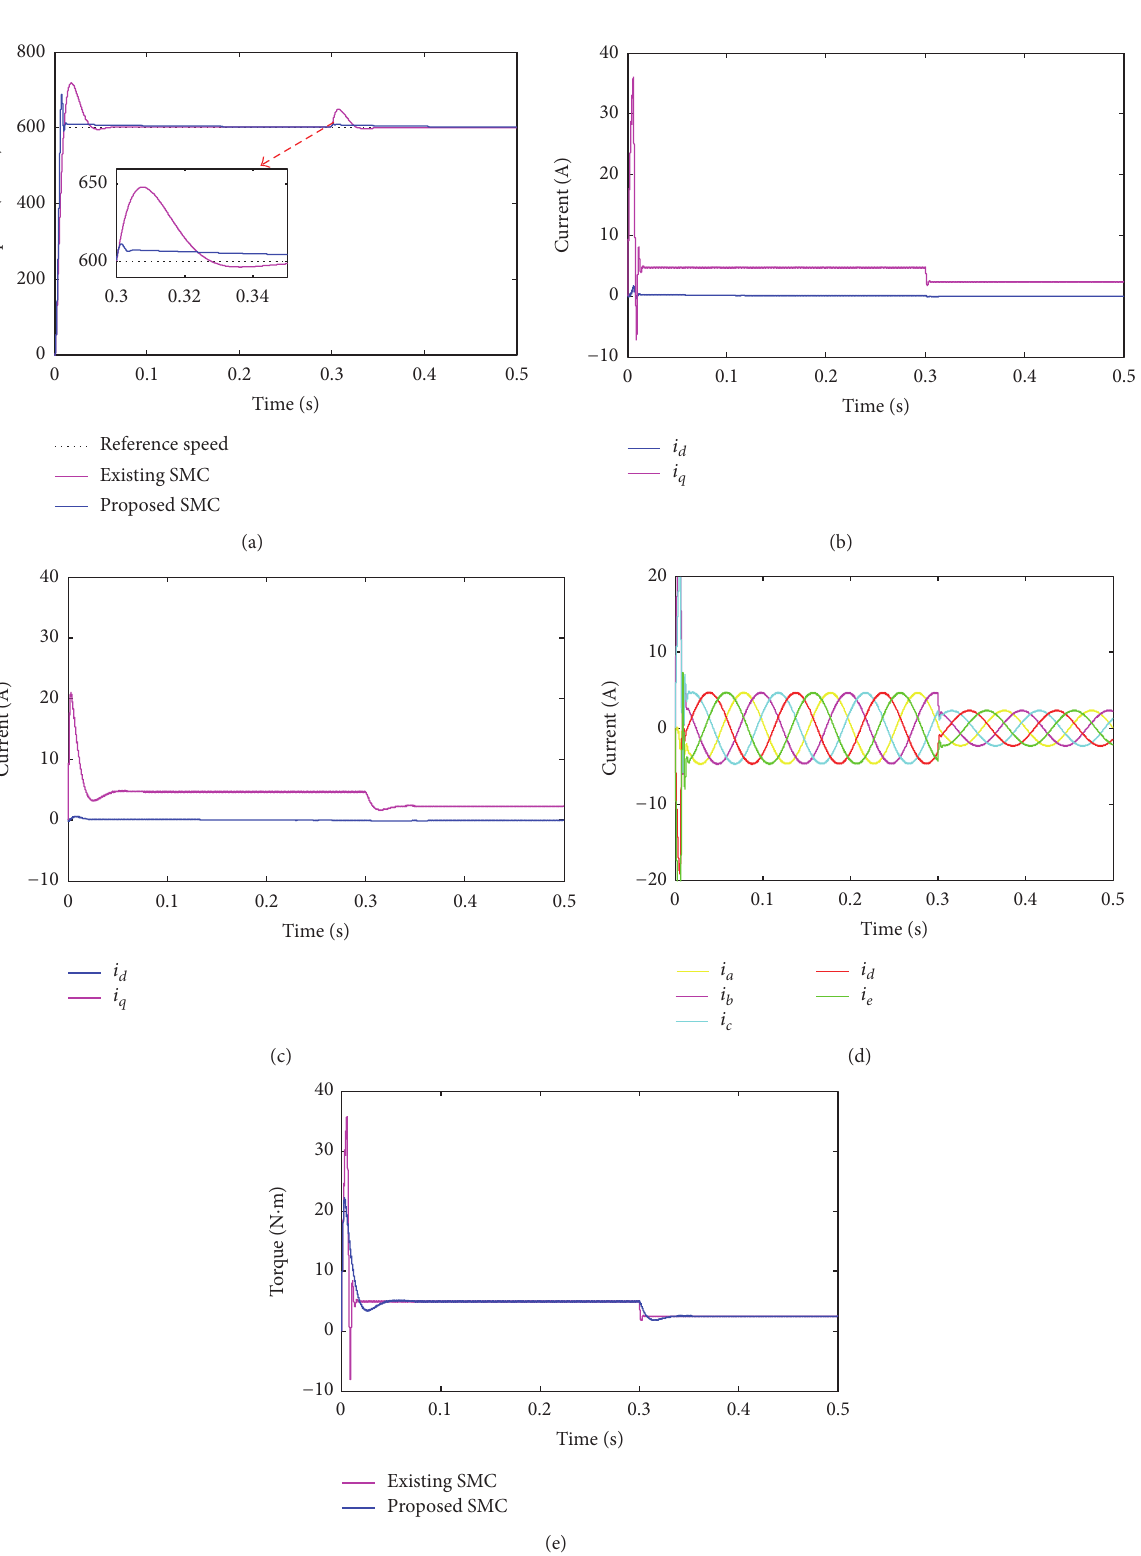
Figure 7: Simulation results when decreasing load from 5 N ⋅ m to 2.5 N ⋅ m. (a) Speed response. (b) Current waveforms 𝑖 𝑑 and 𝑖 𝑞 under the existing SMC. (c) Current waveforms 𝑖 𝑑 and 𝑖 𝑞 under the proposed SMC. (d) Waveforms of the five-phase currents. (e) Torque